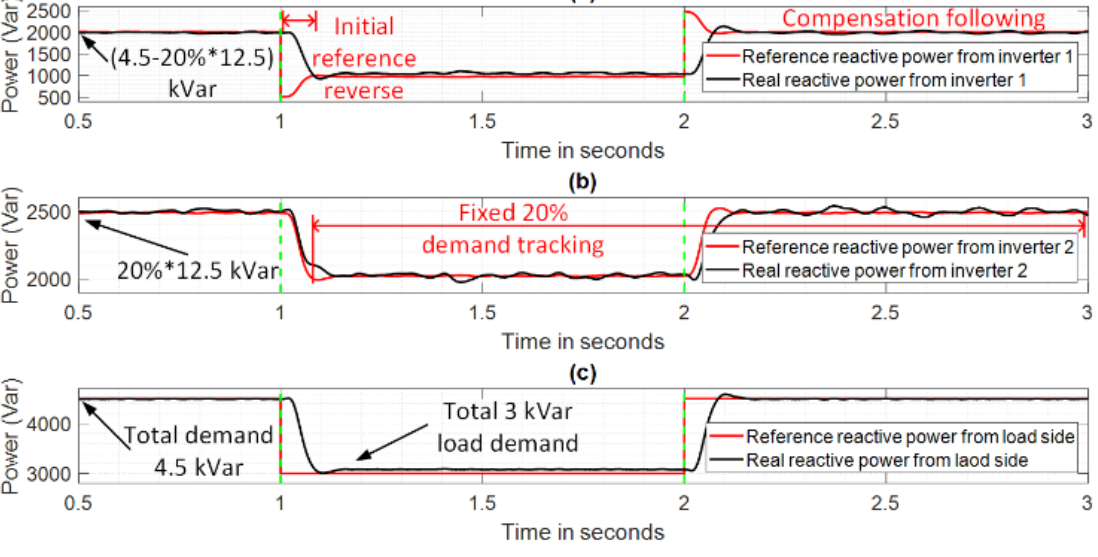
Figure 13. Reactive power tracking result with measured reactive power (black) and reference reactive power (red). ( a ) Reactive power from the first generator, ( b ) reactive power from the second generator, ( c ) total reactive power.